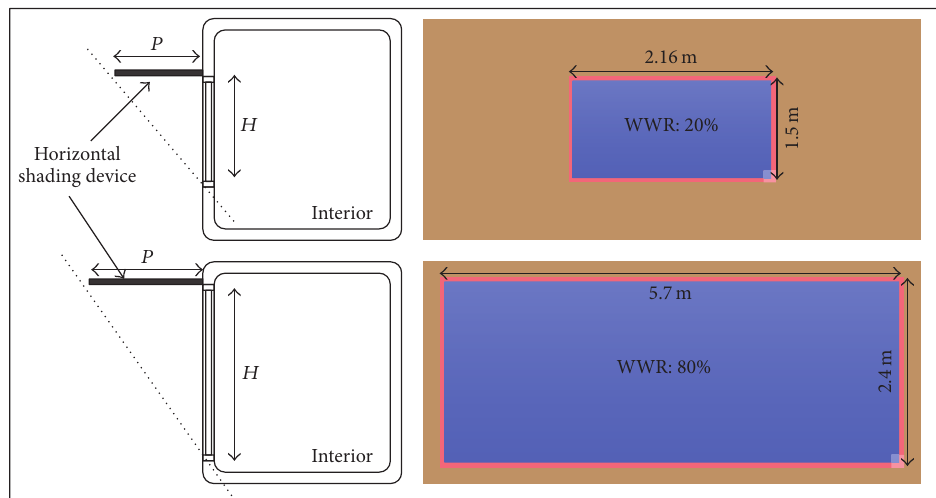
Figure 5: Length difference of horizontal shading device by WWR.